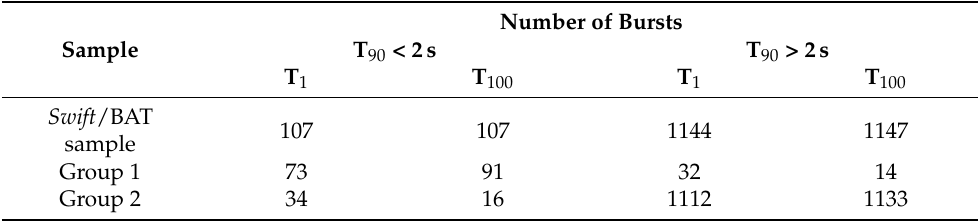
Table 3. Sample sizes of short-duration (T 90 < 2s) and long-duration (T 90 > 2s) bursts in the Swift /BAT sample, and Groups 1 and 2, based on the analysis of the T 1 and the T 100 intervals.